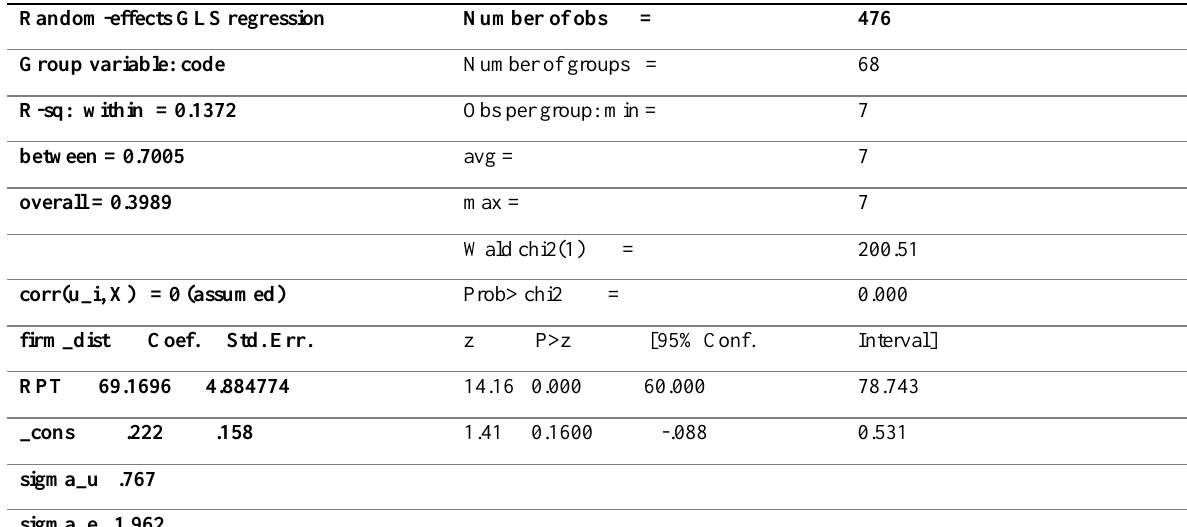
Table 2: Regression Analysis of Related Party Transaction and Probability of Financial Distress Random-effects GLS